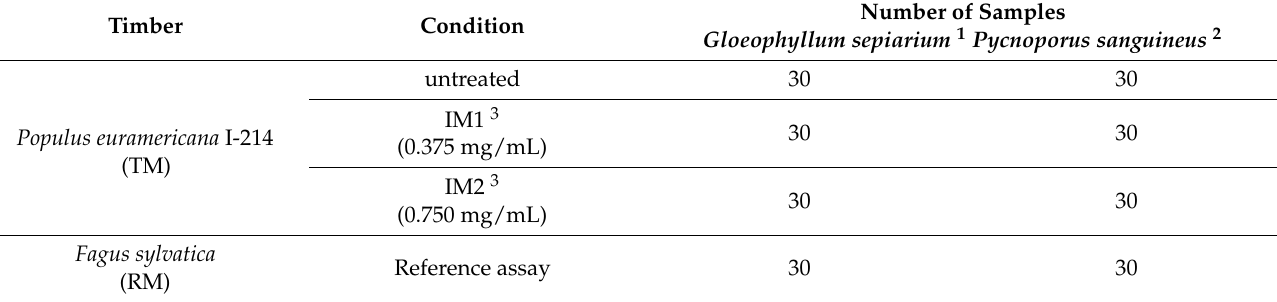
Table 1. Type, condition and distribution of material used for the biodegradation assays (adapted from EN 113-1:2020